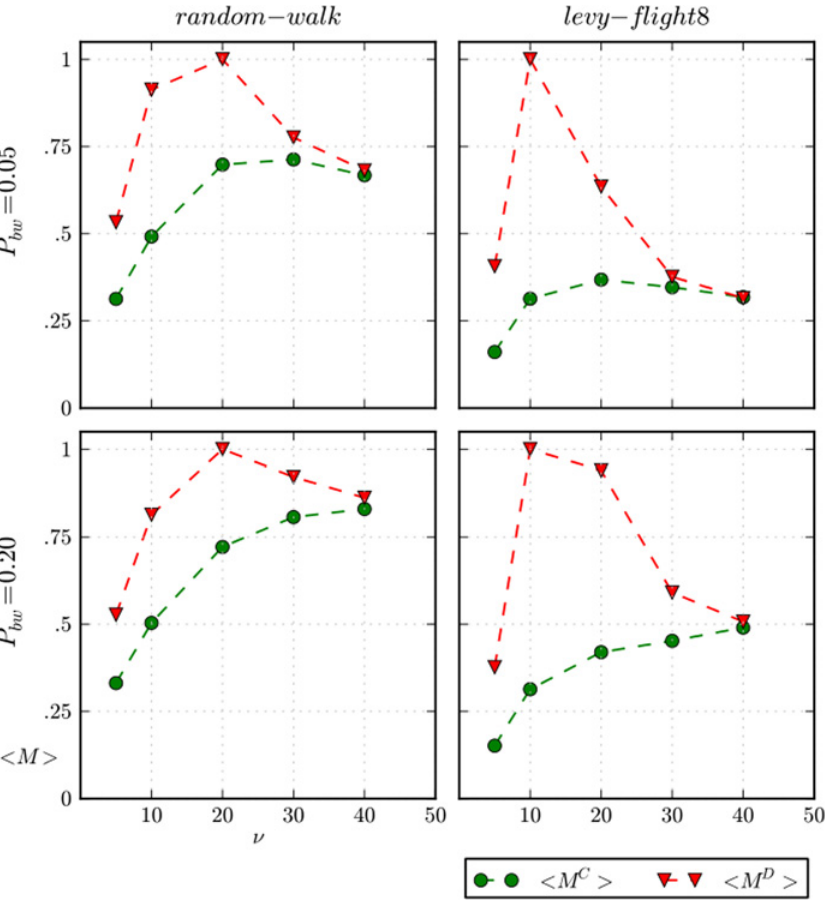
Fig 10. Average amount of meat for cooperators and defectors. Average amount of meat for cooperators M C and defectors M D over a complete simulation run for two values of P bw , and “ random-walk ” and “ Lévy- flight8 ” movements. The spatial distributions of beached whales is uniform and θ = 10 – 1 . 5